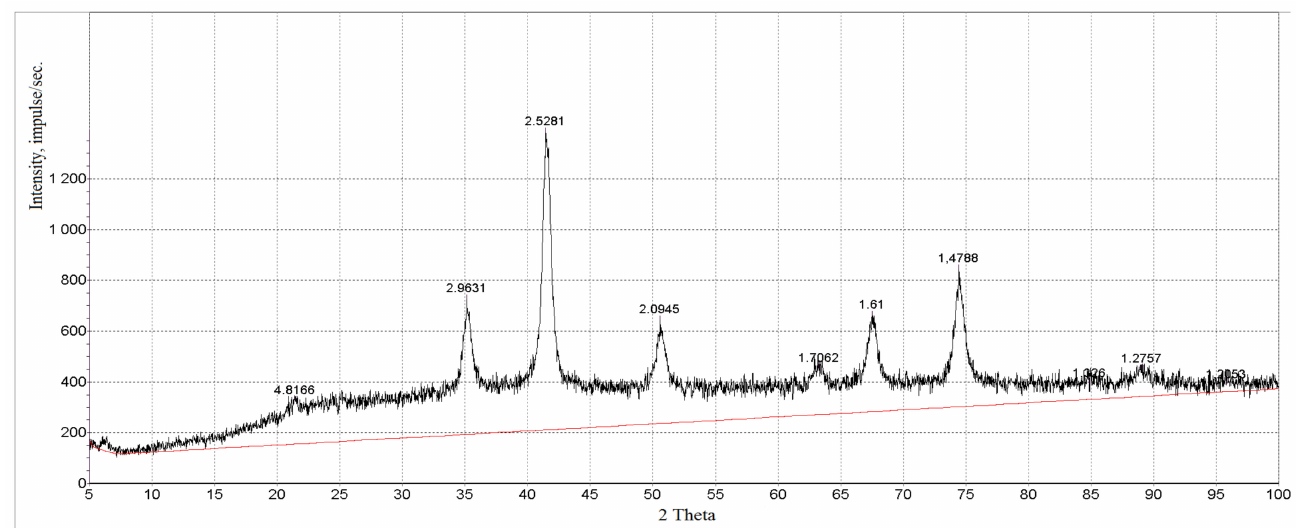
Figure 2. X-ray diffractogram of synthesized iron oxide, magnetic composite.